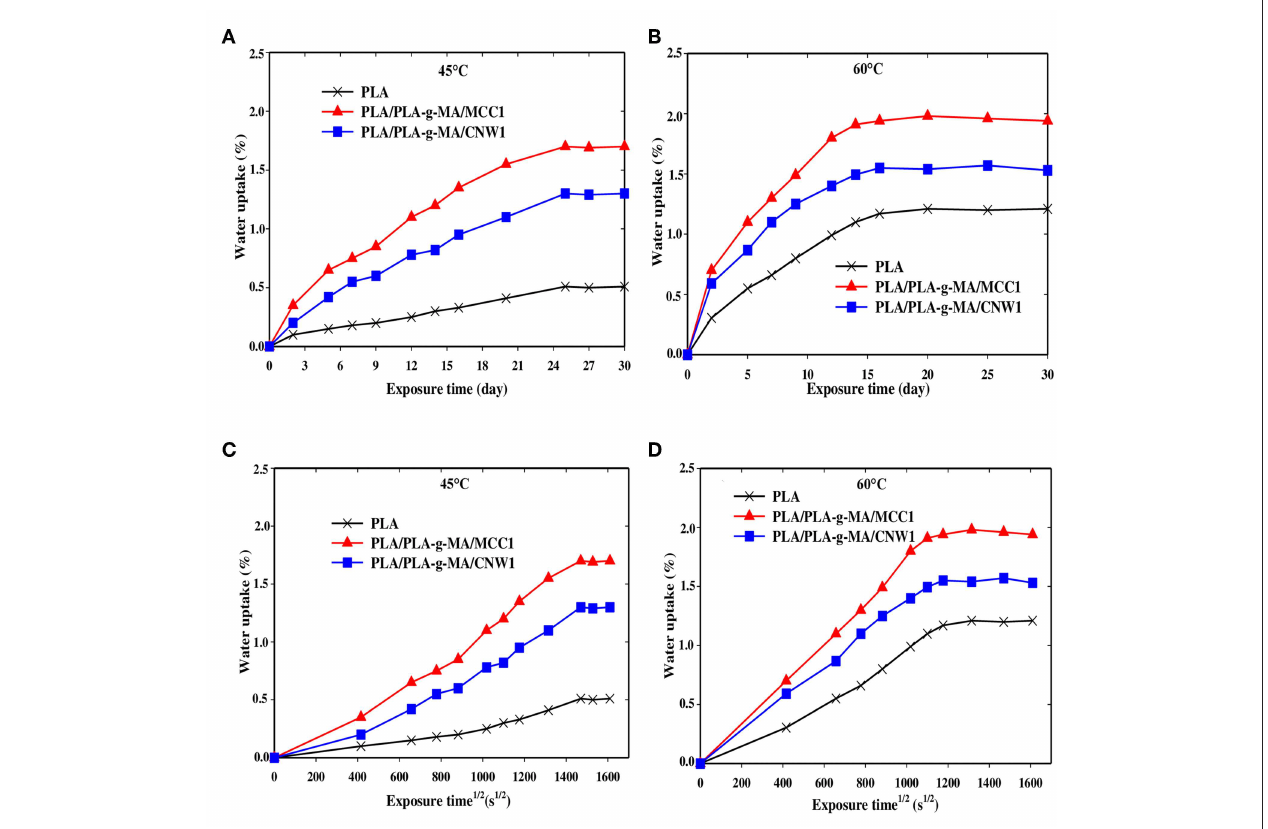
FIGURE 1 | Water uptake curves of PLA, PLA -g- MA/MCC1, and PLA -g- MA/CNW1 fibers vs. exposure time (A) : 45 ◦ C and (B) : 60 ◦ C and root of time (C) 45 ◦ C and (D) : 60 ◦ C, respectively in hygrothermal